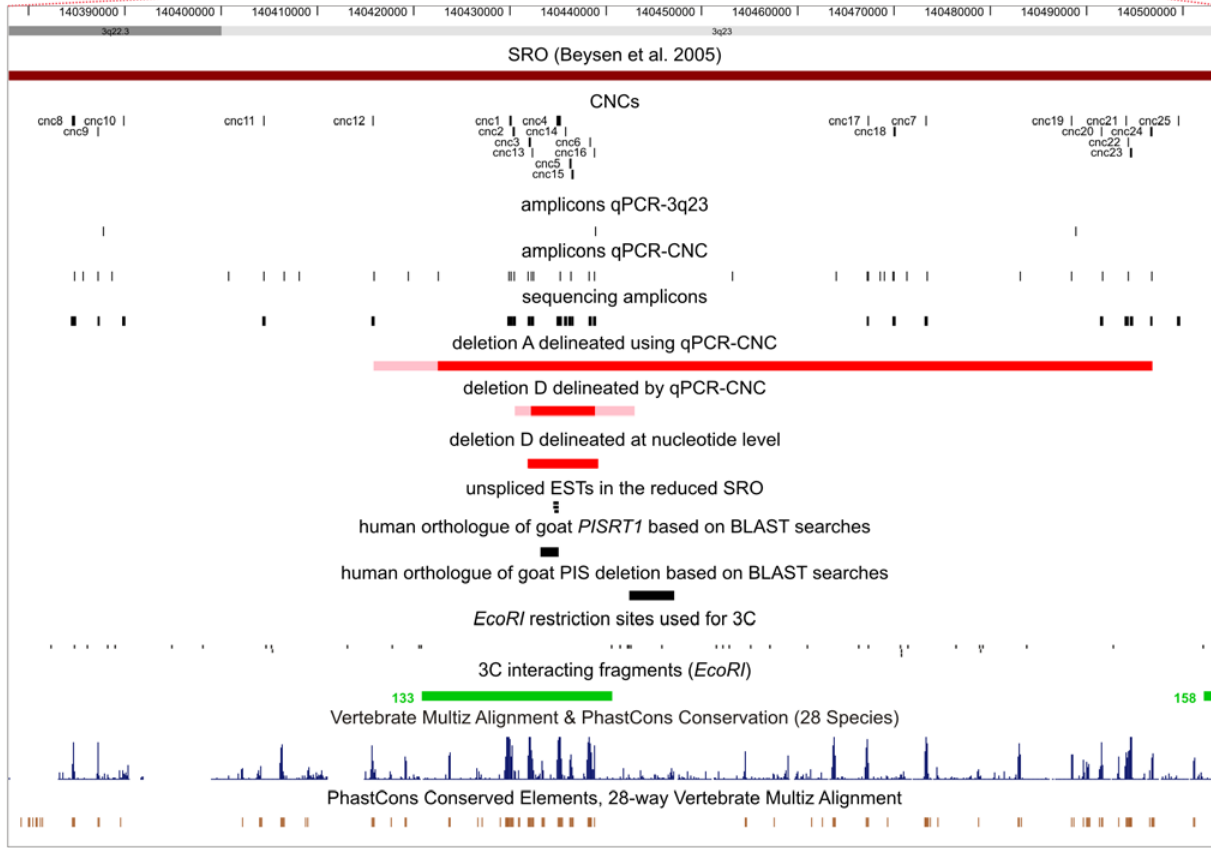
Figure 2. Human Genome Browser view of the initial and reduced SRO. UCSC Genome Browser view of the SRO region (chr3:140,377,900– 140,504,100) with: 25 CNCs mapping within the initial SRO; 3 amplicons of the qPCR-3q23 assay located in the initial SRO; 36 amplicons designed for the qPCR-CNC assay; the amplicons designed for sequencing analysis of CNCs and the two deletions delineated by qPCR-CNC (A,D). The red bars indicate the minimal deleted regions and the pink bars indicate the maximum deleted region. The next track indicates the delineation of deletion D at nucleotide level. The remaining tracks at the bottom display: unspliced ESTs in the reduced SRO; the human orthologue of caprine PISRT1 based on BLAST searches; the human orthologue of the PIS deletion based on BLAST searches; the Eco RI restriction sites used for 3C; in green the 3C fragments (133, 158) interacting with the fragment containing the FOXL2 promotor; the conservation profile of the region extracted from the UCSC genome browser (blue and brown). The figure was drawn according to the UCSC, Human Genome Browser, March